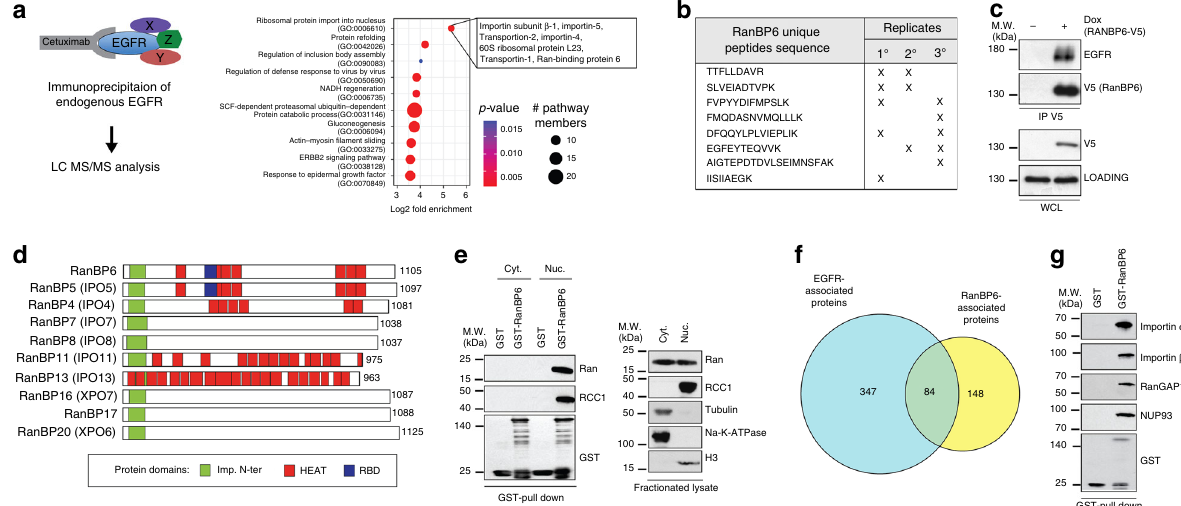
Fig. 1 Importin β -like protein RanBP6 interacts with EGFR. a Left panel, schematic representation of EGFR immunoaf fi nity puri fi cation and LC-MS/MS analysis in A431. Right panel, plot showing the ten top categories of the gene ontology enrichment analysis of the EGFR-associated proteins. b List of the unique peptides for RanBP6 identi fi ed in the MS analysis and the replicate in which the peptide was identi fi ed are indicated in the table. c Co- immunoprecipitation of EGFR and V5 epitope-tagged RanBP6-V5 in A431 cells. Top panel, IP using V5 antibody; bottom panel, immunoblot of whole-cell lysates (WCL). d Conserved domains within the family of importin β -related proteins. RanBP6 includes an importin β -like N-terminal domain (Imp. N-ter), seven HEAT repeats, and a putative Ran-binding domain (RBD). The number to the right of each protein shows the total number of amino acids. e RanBP6 interacts with nuclear but not cytoplasmic Ran-GTPase. Subcellular fractionation of HEK-293T cells (right panel) shows that Ran is present in both nuclear and cytoplasmic compartments, but only interacts with RanBP6 in the nuclear fraction (left panel). f Venn diagram representing overlapping proteins between the RanBP6-V5 and the EGFR immunoaf fi nity puri fi cations. See Supplementary Data 5. g GST pulldown assay con fi rms the interaction of RanBP6 with importin- α 1, importin- β 1, RanGAP1, and nuclear pore complex 93 (NUP93) in HEK-293T whole-cell